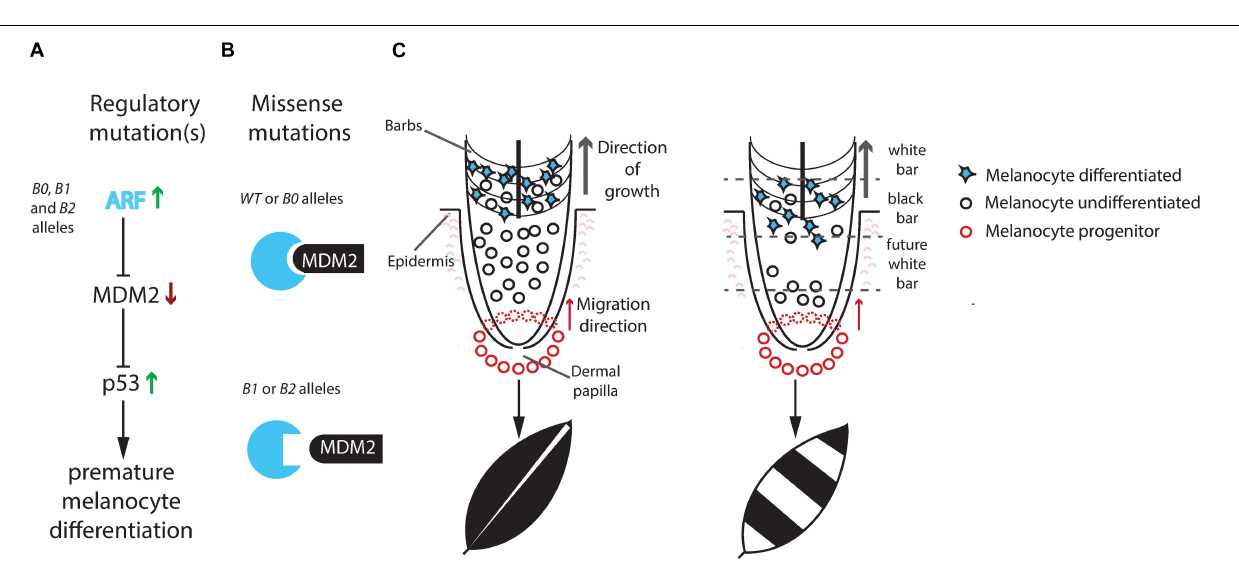
FIGURE 3 | Proposed mechanism for development of the Sex-linked barring phenotype. (A) The non-coding mutation(s) present in the B0 , B1 , and B2 alleles cause a tissue-specific upregulation of CDKN2A encoding the ARF protein. ARF inhibits MDM2-mediated degradation of p53. p53 will activate downstream targets possibly initiating premature melanocyte differentiation resulting in a loss of mature pigment cells. (B) The amino acid substitutions associated with the B1 and B2 alleles impair the ARF/MDM2 interaction, which counteracts the consequences of upregulated ARF expression. (C) In wild-type feathers, melanocyte progenitor cells migrate up from the feather base and start expressing ARF in the barb region leading to differentiation of melanocytes and pigment production without exhausting the pool of undifferentiated melanocytes. In Sex-linked barred feathers, upregulated ARF expression may lead to premature differentiation of pigment cells and a lack of undifferentiated melanocytes that can replenish the ones producing pigment. As the feather keeps on growing, no more melanocytes are available to produce pigment resulting in the white bar. A plausible explanation for the periodic appearance of white and black bars is that new recruitment of melanocyte progenitor cells takes place after the undifferentiated melanocytes have been depleted. From Schwochow-Thalmann et al.